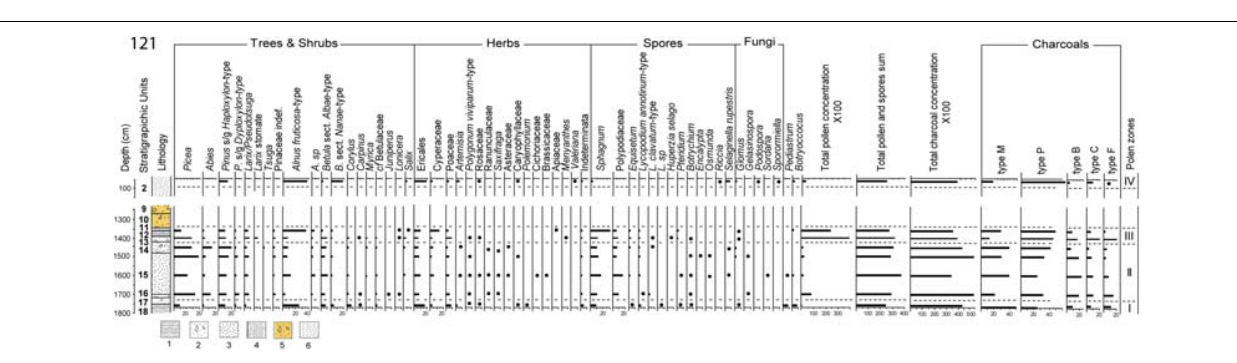
FIGURE 6 | Percentage pollen, spore, and non-pollen-palynomorph and charcoal diagram of site 121 (for location see Figure 1B ). 1 – brownish basaltic tuff debris with sand and fine-sand loam; 2 – yellow-brown pebble bed with sand; 3 – dark-gray pebble bed with well-rounded pebbles, sand and debris; 4 – grayish brown lignified plant remains (wood, cones, leaves); 5 – grayish brown pebble and boulder bed with impact glasses; 6 – laminated coarse yellow-brown pebble